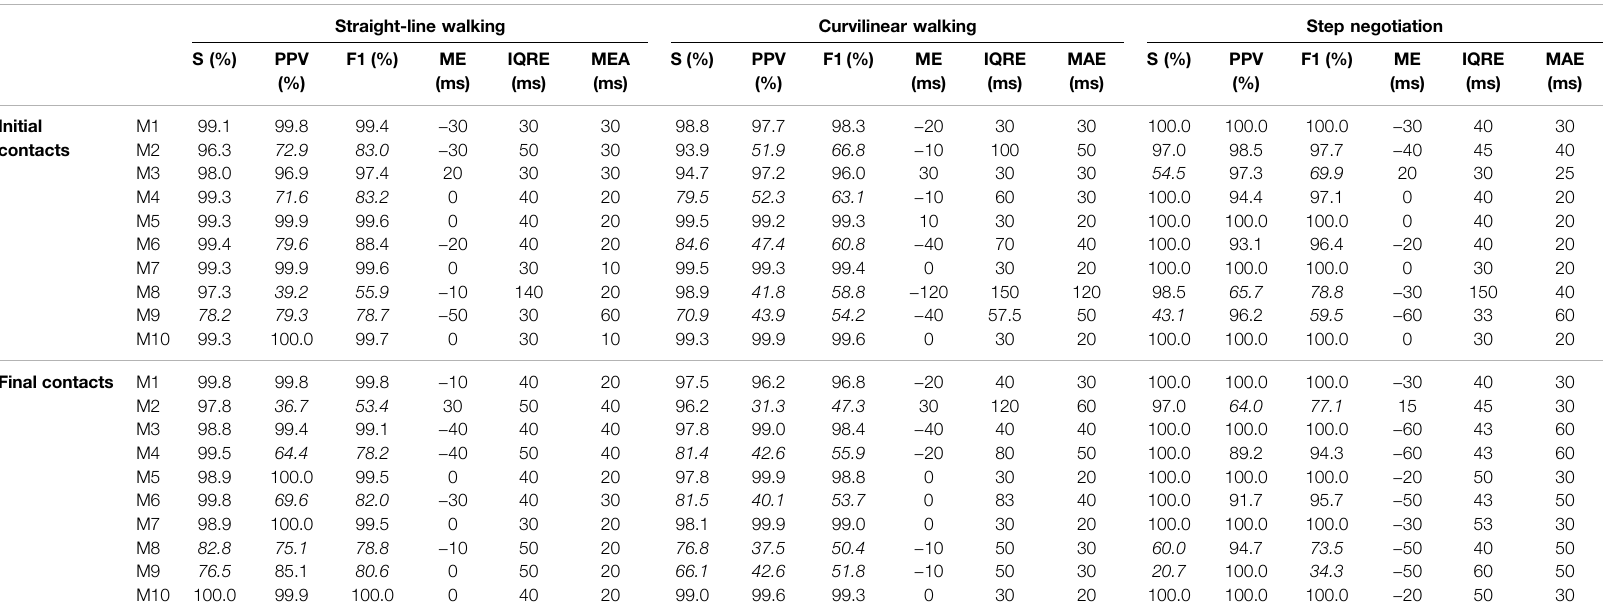
TABLE3| Performances ofthe10methods (M1 ... M10)indetectingboth initialand fi nalcontactsintheyounghealthyadultcohortinstraight-linewalking( SW ),curvilinear walking( CW ),andstepnegotiation( SN ),reported in terms of sensitivity ( S ), positive predictive values (PPV), F1 scores, median error (ME, i.e., bias), inter-quartile range error (IQRE, i.e., precision), and median absolute error (MAE, i.e., accuracy). S , PPV, and F1 values lower than 85% have been highlighted in